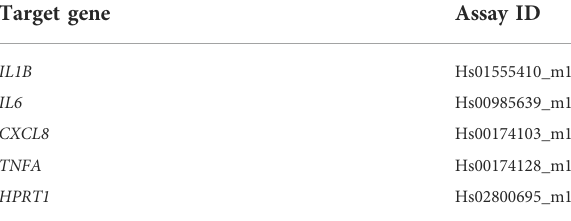
TABLE 2 Primers used for gene expression